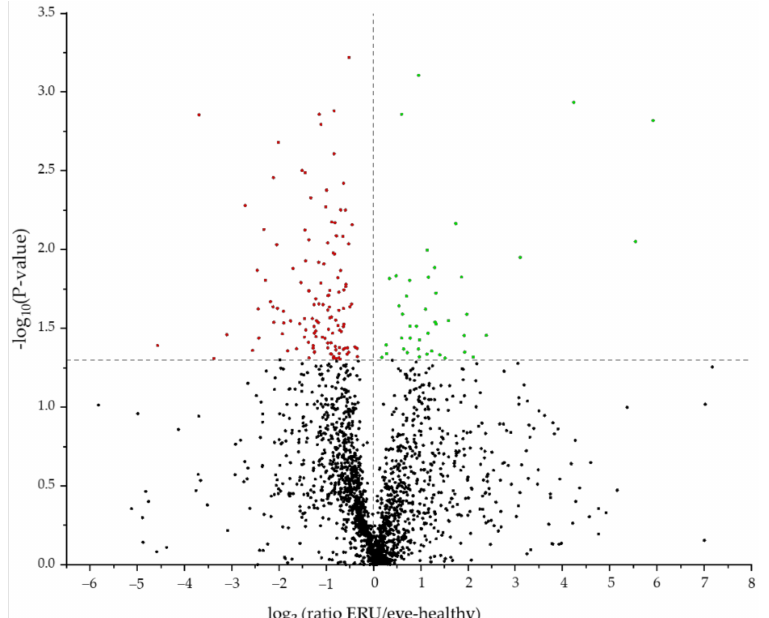
Figure 1. Volcano plot of the 2012 proteins detected by mass spectrometry post IL8 stimulation. The 170 differentially abundant candidates ( p < 0.05) between controls and ERU cases are displayed above the grey line. More abundant proteins are displayed in green, and less abundant proteins are marked